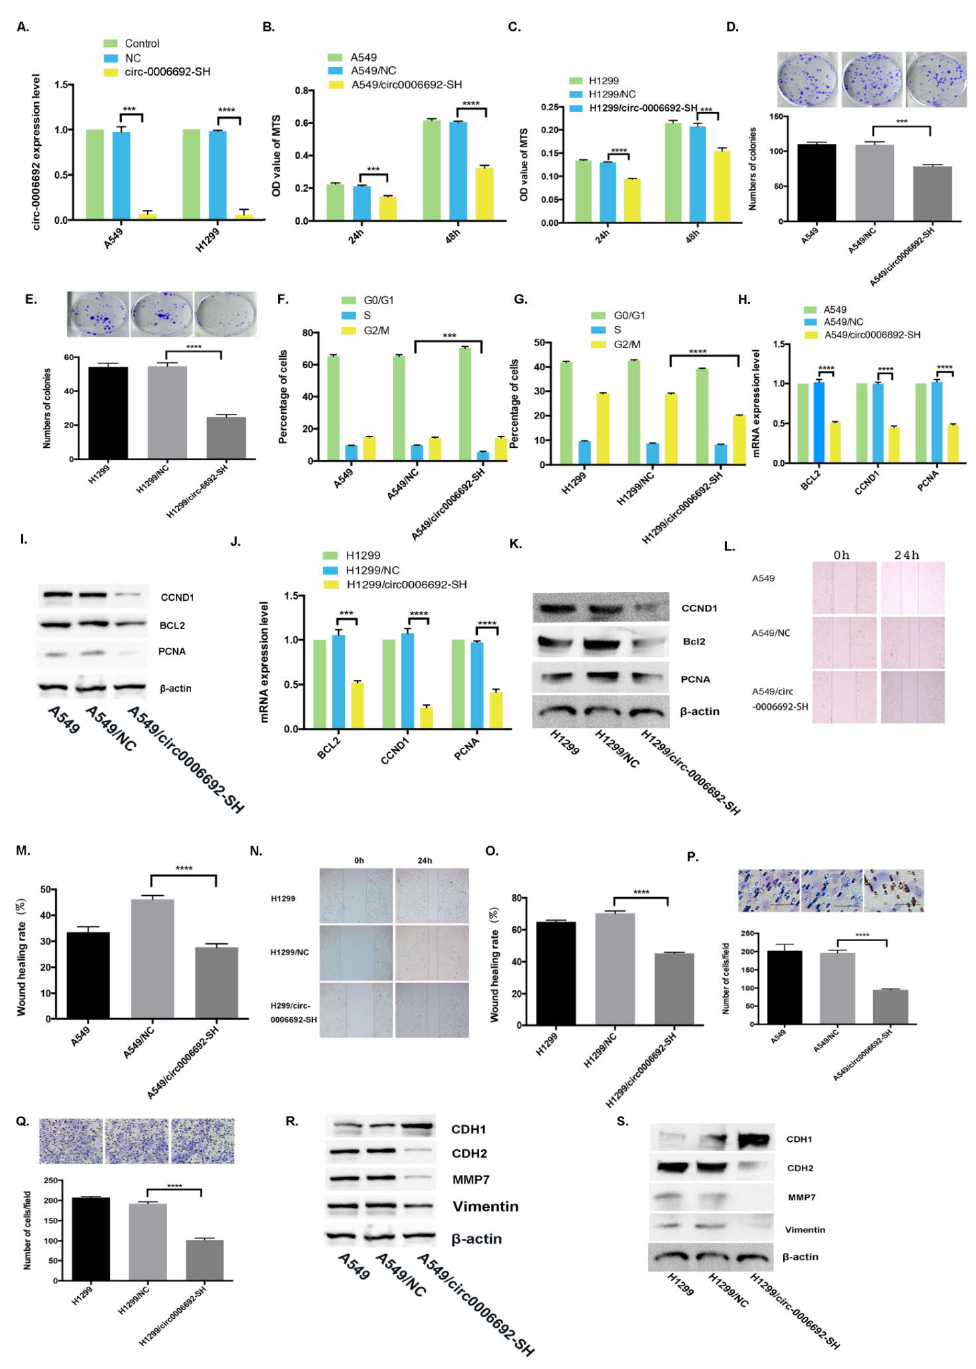
Figure 3. Silence of hsa_circ_0006692 inhibited the proliferation, migration, and invasiveness of A549 and H1299 cells. ( A ) qPCR on hsa_circ_0006692 expression in A549 and H1299 cells. ( B , C ) The roles of hsa_circ_0006692 silencing in the vitality of A549 and H1299 cells measured using the MTS assay; ( D , E ) The roles of hsa_circ_0006692 silencing in the colony formation of A549 and H1299 cells; ( F , G ) The roles of hsa_circ_0006692 knockdown in cell cycle distribution of A549 and H1299 cells measured with FACS; ( L – O ) The roles of hsa_circ_0006692 silencing in the migration of A549 and H1299 cells measured with wound healing assay; ( P , Q ) The roles of hsa_circ_0006692 silencing in the invasiveness of A549 and H1299 cells measured with the transwell invasive assay; ( H – K ) The expression of proliferation-related-genes BCL-2 , CCND1 , and PCNA were detected by qRT-PCR and WB; ( R , S ) The expression of EMT-associated genes, MMP7 , VIMENTIN , CDH1 , and CDH2 demonstrated by WB. *** p < 0.001; **** p <